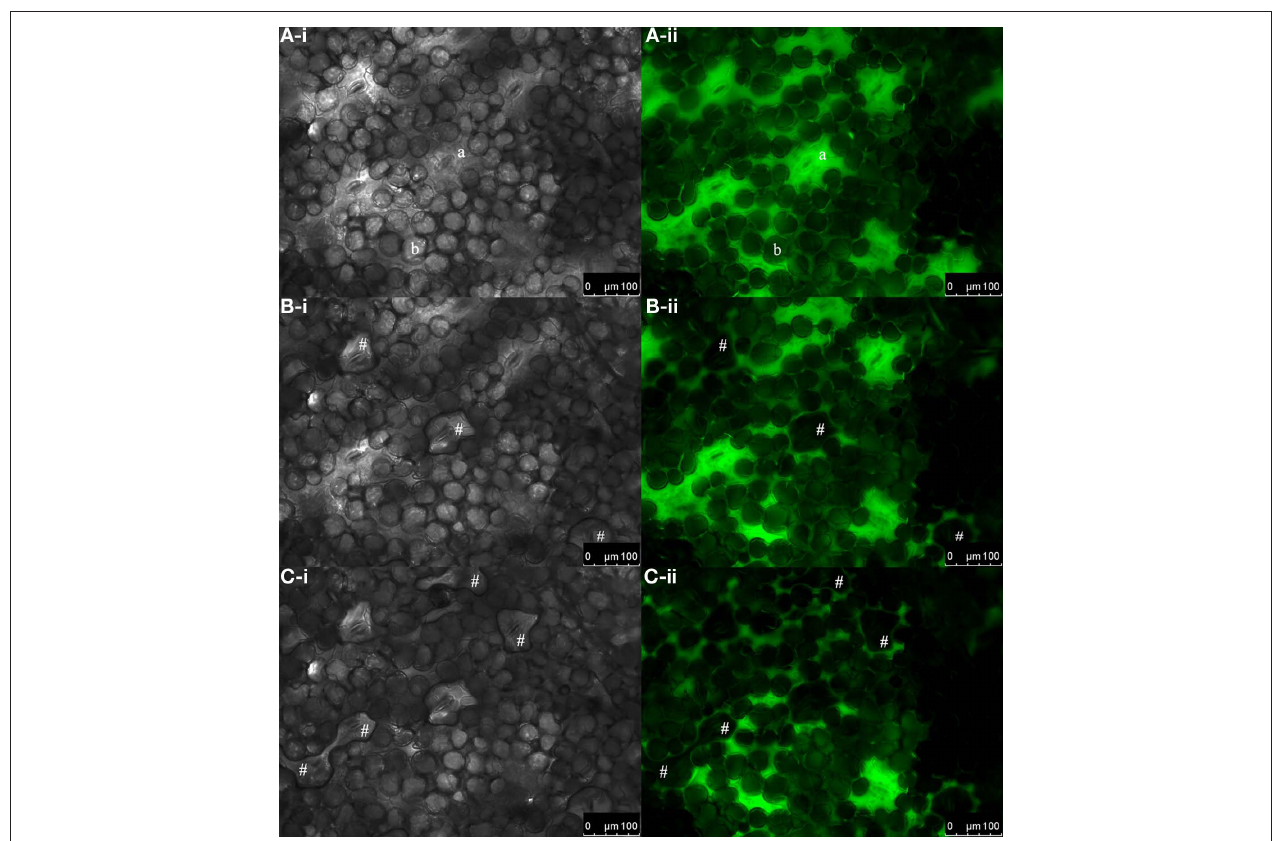
Figure 2 | excessive water exits the apoplast through the stomata. Bright-field images of the adaxial leaf face (gray-scaled; A-i , B-i , and C-i ) and corresponding pseudo-green fluorescence images at ex 495 nm ( A-ii, B-ii , and C-ii ). Images were collected (A) immediately after dye loading and at (B) 2 min and (C) 10 min after loading. (A-i, -ii) Immediately after loading, no water droplets are found to be located onto the stomata. (B-i) Water droplets that had